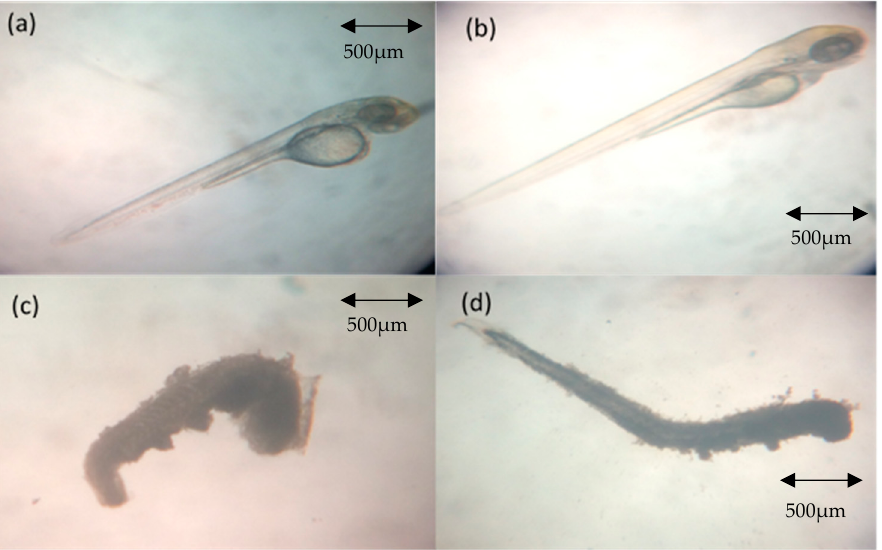
Figure 1. Normal and coagulated zebrafish embryos. ( a ) At 48 h post fertilization (hpf) (24 h post ‐ irradiation) from negative control group (normal development); ( b ) at 72 hpf (48 h post ‐ irradiation) from negative control group (normal development); ( c ) at 48 hpf (24 h post ‐ irradiation) from the treatment groups (coagulated); ( d ) at 72 hpf (48 h post ‐ irradiation) from the treatment groups. The coagulation in zebrafish embryos from the irradiated without treatment (IN), irradiated with KH treatment (IKH) and irradiated with amifostine treatment (IA) groups was observed at 24 and 48 h post ‐ irradiation. The percentage of coagulated zebrafish em ‐